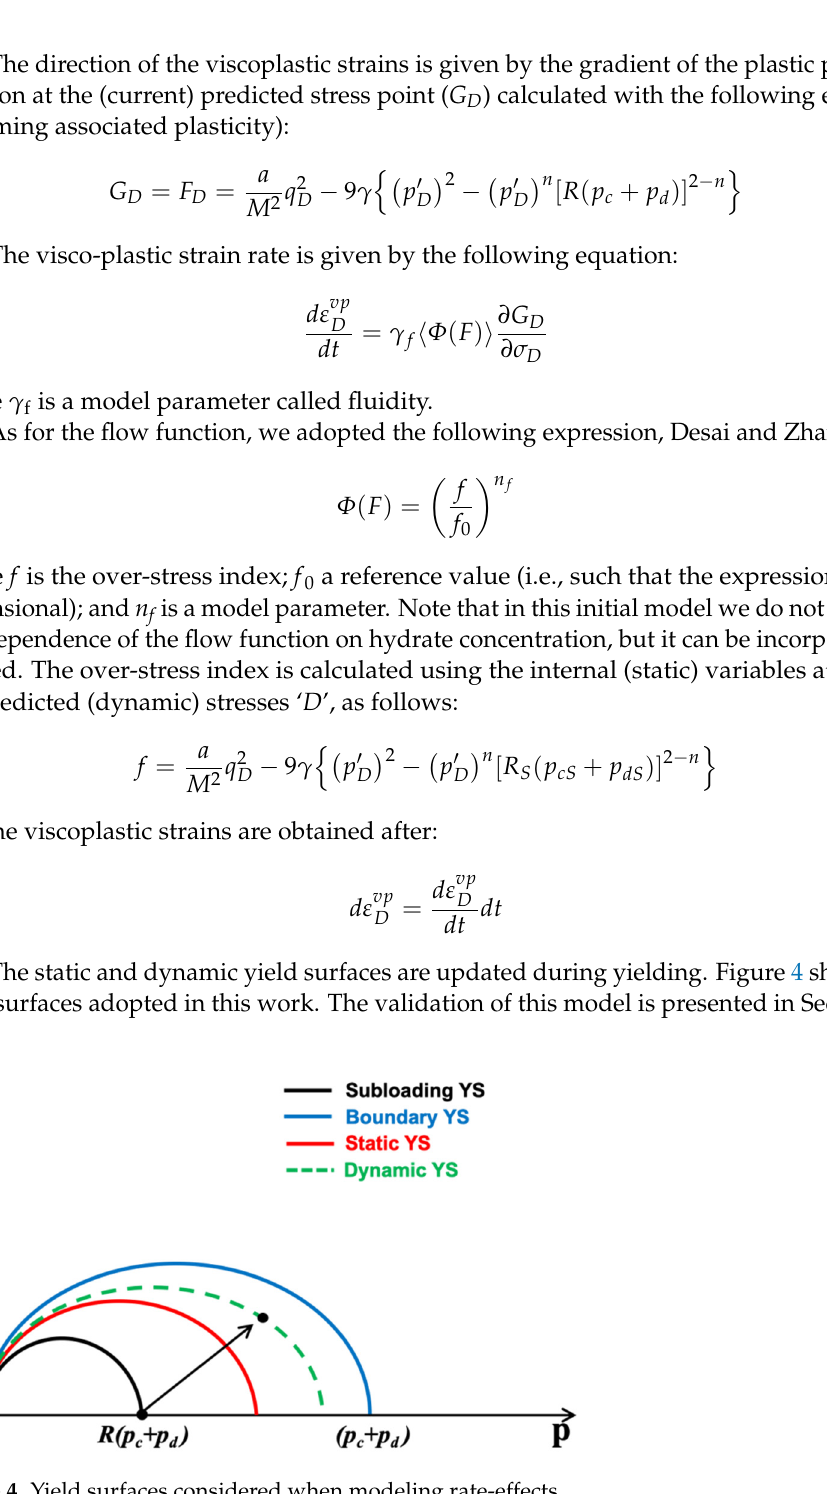
Figure 4. Yield surfaces considered when modeling